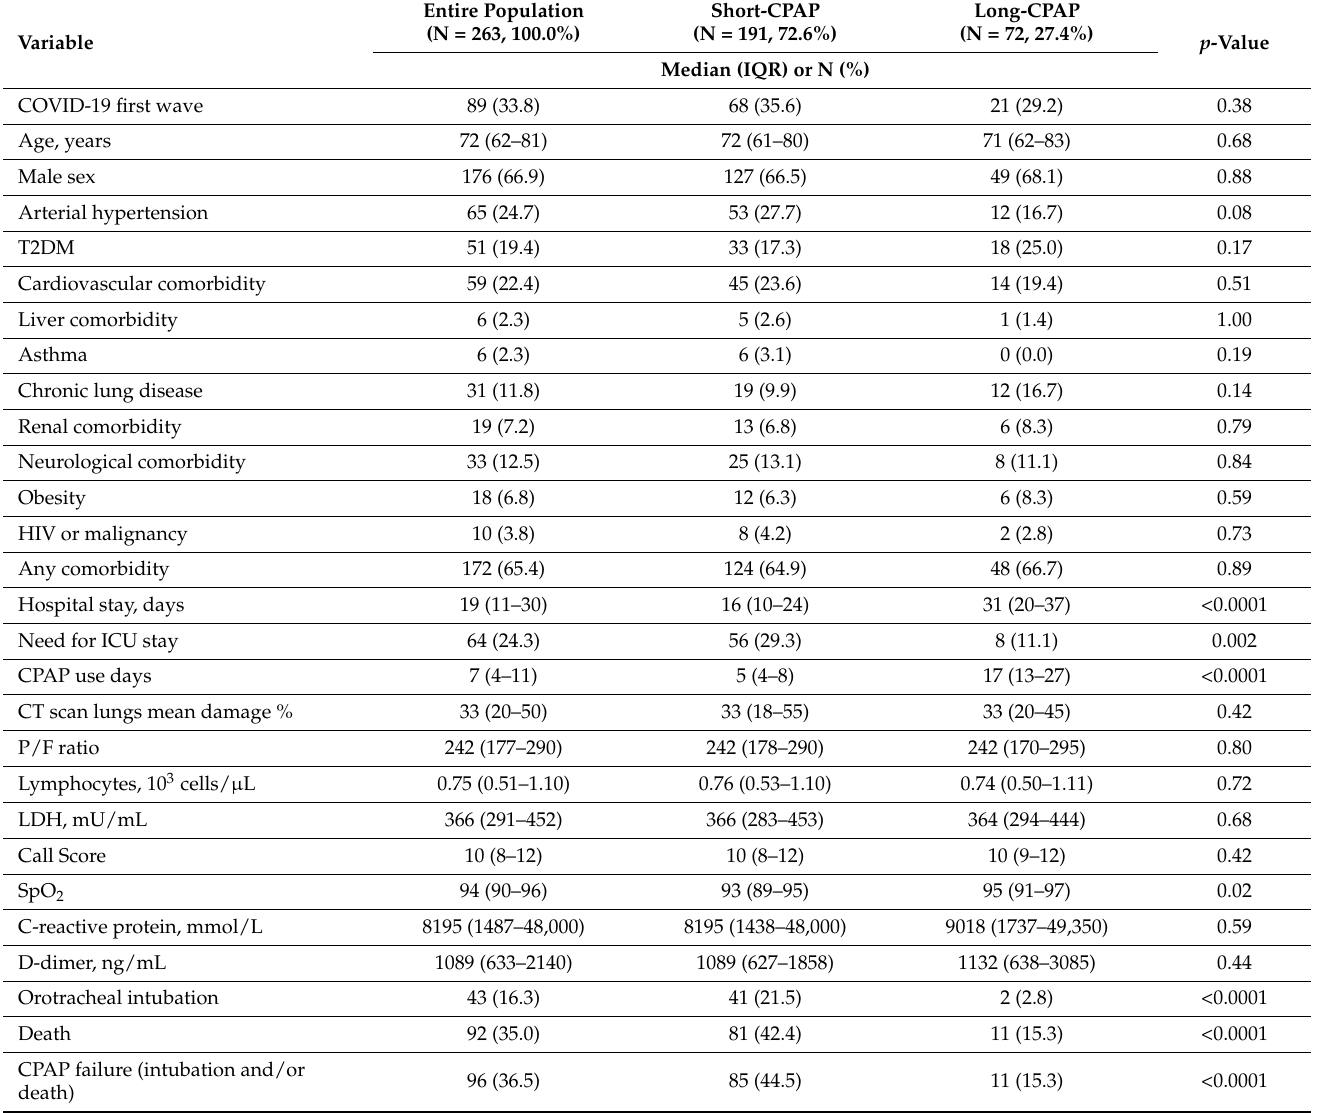
Table 1. Characteristics of the COVID-19 population treated with